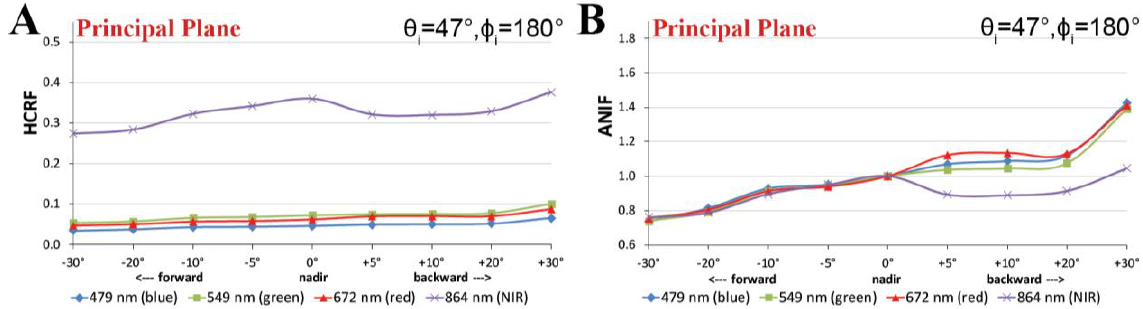
Figure 10. ( A ) HCRF values versus view zenith angles in the solar principal plane. ( B ) Anisotropy factors (ANIF) versus view zenith angles in the solar principal